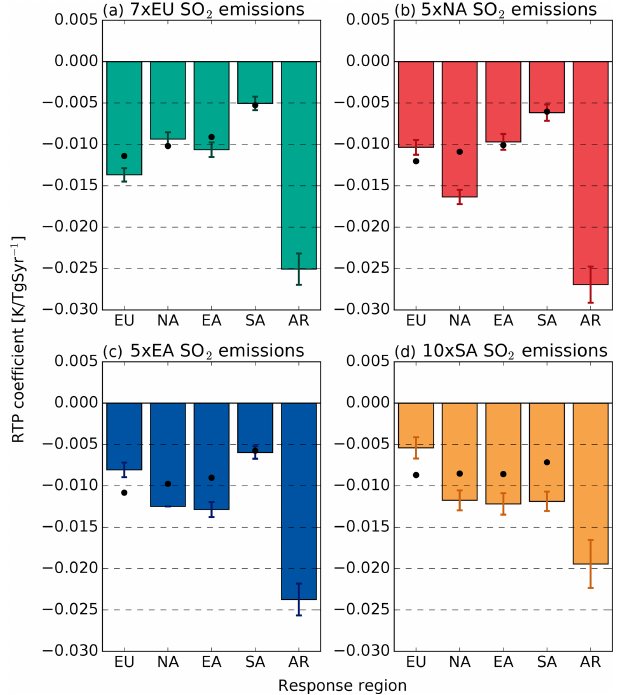
Figure 9. Regional RF and ERF for SO 2 emission (Wm − 2 (TgSyr − 1 ) − 1 ) for (a) EU emissions, (b) NA emis- sions, (c) EA emissions and (d) SA emissions. In each pair of bars the left bar indicates RF and the right bar indicates ERF. Grey shading indicates that the forcing response is not statistically significant ( p > 0 . 05) compared to the control simulation. The error bars show the standard error.